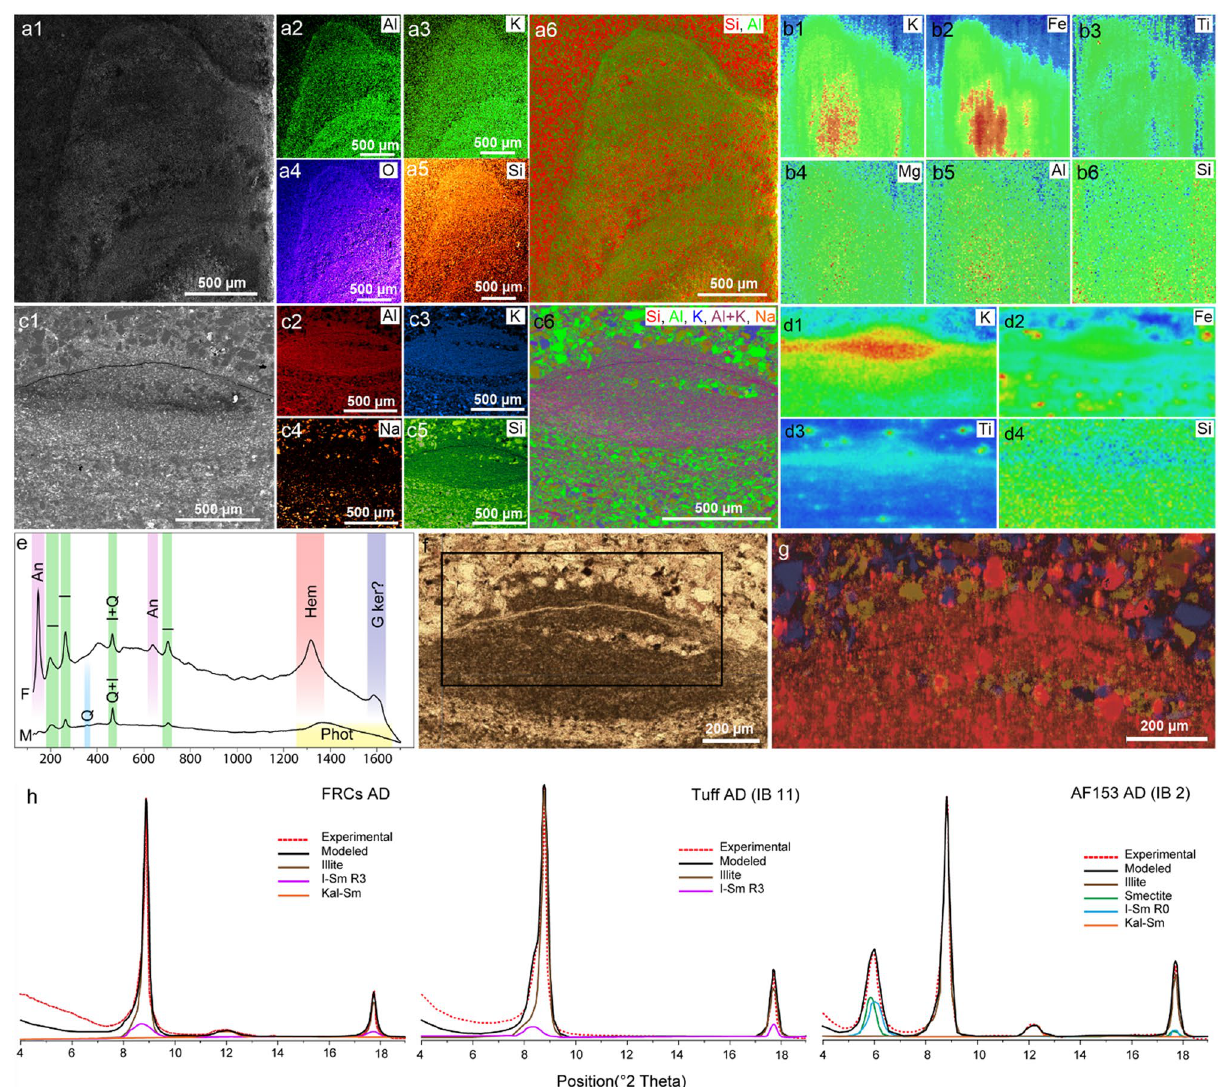
Figure 3. Geochemical analyses of the fossil-related clays (FBCs) in three-dimensionally preserved microbial mats. ( a ) SEM image and EDS maps of a region diagonally crosscutting a 3D preserved tufted microbial mat (see Supplementary Fig. S6), highlighting the concentration of Al and K in the biogenic structure. ( b ) SR-µXRF maps of the same region, showing increased intensities of K, Fe, Ti, Mg and Al in the fossil-bearing clays. ( c ) SEM image and EDS maps of a cross-section through a 3D preserved Arumberia-type microbial mat (see Supplementary Fig. S6), revealing relatively higher intensities of Al and K in the fossil. ( d ) SR-µXRF of the same region as in ( c ), showing enrichments and spatial relations of K, Fe and Ti with the microbial mat. ( e ) Representative Raman spectra of FBCs (F) and rock matrix (M). An anatase, I illite, Q quartz, Hem disordered hematite (see Ref. 46 ), G ker possible G band of kerogen, Phot artifact of photoluminescence from the glass. ( f , g ) Raman mapping of anatase (red), quartz (blue) and plagioclase (yellow) of the Arumberia sample. Note the concentration of disseminated and fine-grained anatase in the fossil. ( h ) XRD patterns (air-dried) and NEWMOD modeling of the FBCs, the tuff sample, and a distal delta-front mudstone sample. Figures created using INCA ( a , c ; https ://www.etas.com/en/produ cts/inca_softw are_produ cts.php), PyMCA 5.4.0 ( b , d ; http:// pymca .sourc eforg e.net/), WiRE ( e – g ; https ://www.renis haw.com/) and NEWMOD 2.0 ( h ) mixed-layer minerals (R3 I–S MLMs) as suggested by the shoulder on the left side of the illite peak (at 10 Å) and further confirmed by NEWMOD modelling (Supplementary Figs. S12 and S13). As a comparison, the clay assemblages from facies with no fossil-bearing clays are represented by smectite and randomly ordered R0 I/S MLMs (Fig. 3h, Supplementary Text 2, and Supplementary Figs. S8–S18), as well as kaolinite/smectite and Chl-S MLMs that originated during weathering and late diagenetic processes, respectively (Supplementary Text 2). Moreover, the prevalence of the 2 M polytype suggests that most of the illite/muscovite from these samples are detrital in origin. At higher resolution, the XRD data show that the FBCs exhibit a higher proportion of illite than the clays from the adjacent VL of the same beds, and the tuffs and tuffites (Fig. 3h, Supplementary Figs. S11 and S12). SEM